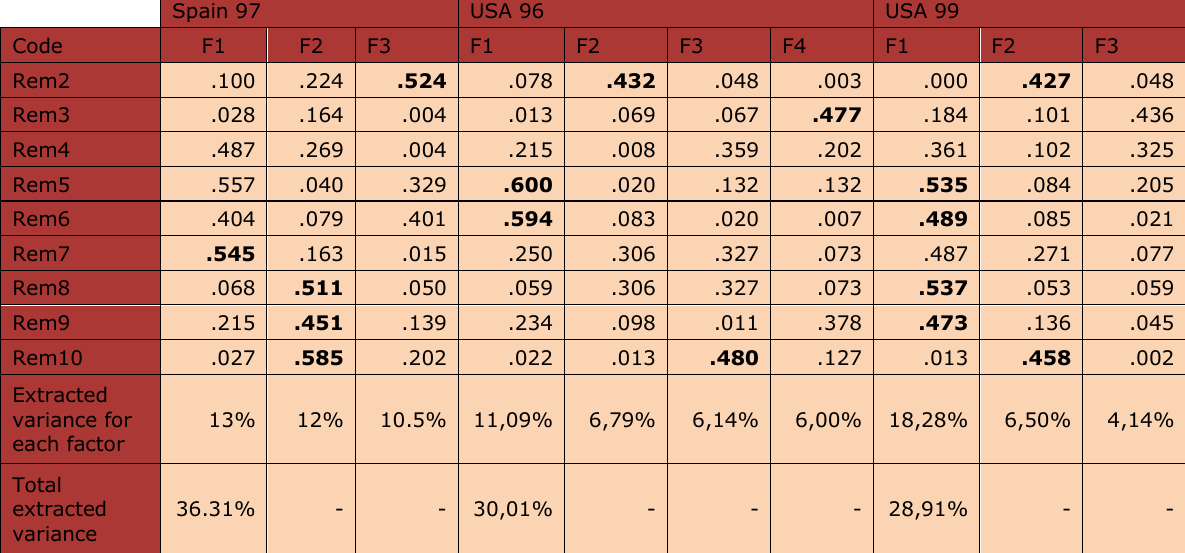
Table 11. Exploratory factorial of rewards practices. In bold, those values above .30, that are only higher to that value in a single factor and that differ from more than 0.30 of the charges in other factors for the same variable